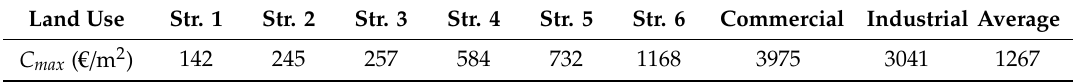
Table 1. C max values for di ff erent social Stratum (Str) linked to land uses. Land Use Str.